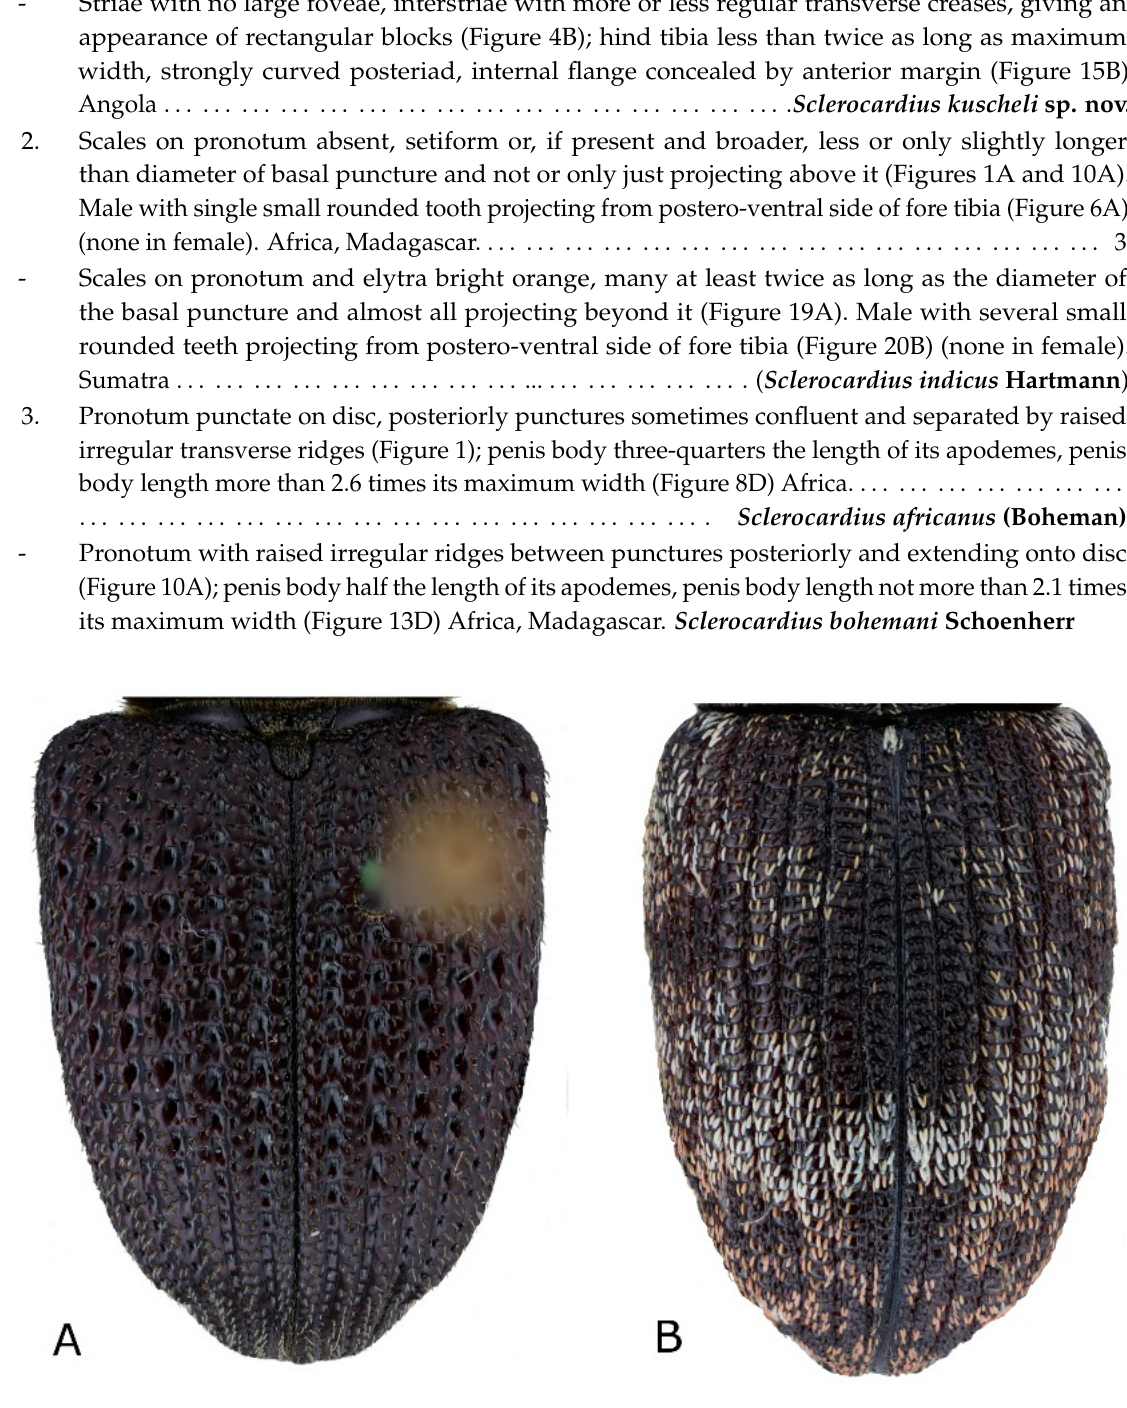
Figure 4. Sclerocardius spp., elytra: ( A ) Sclerocardius africanus , and ( B ) Sclerocardius kuscheli .